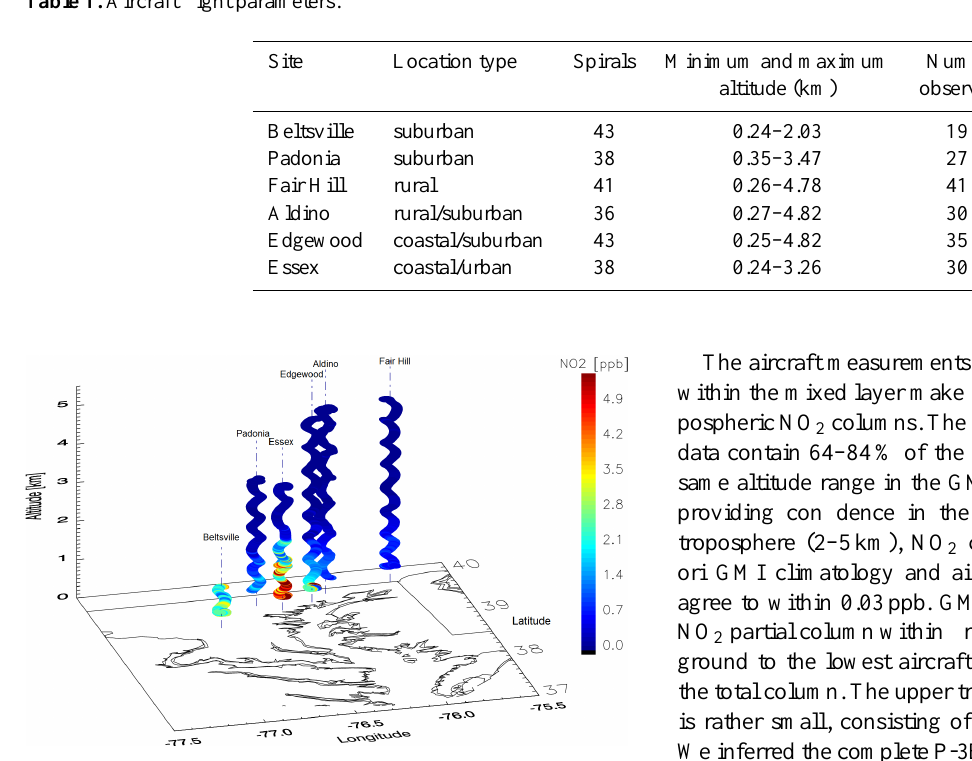
Figure 1. Distribution of NO 2 on 21 July 2011 obtained from P-3B aircraft measurements during the DISCOVER-AQ field campaign in Maryland. More than 190000 1s NO 2 measurements were taken during 254 spirals over the entire campaign